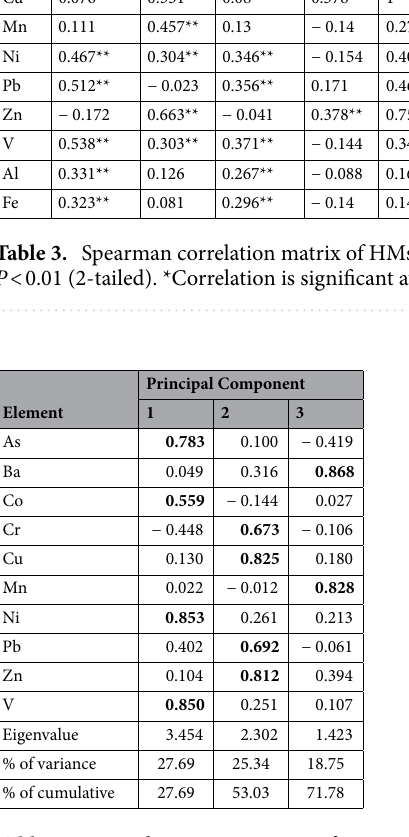
Table 4. Rotated component matrix for HM data in the topsoil of Mianyang. Significant values are in bold.